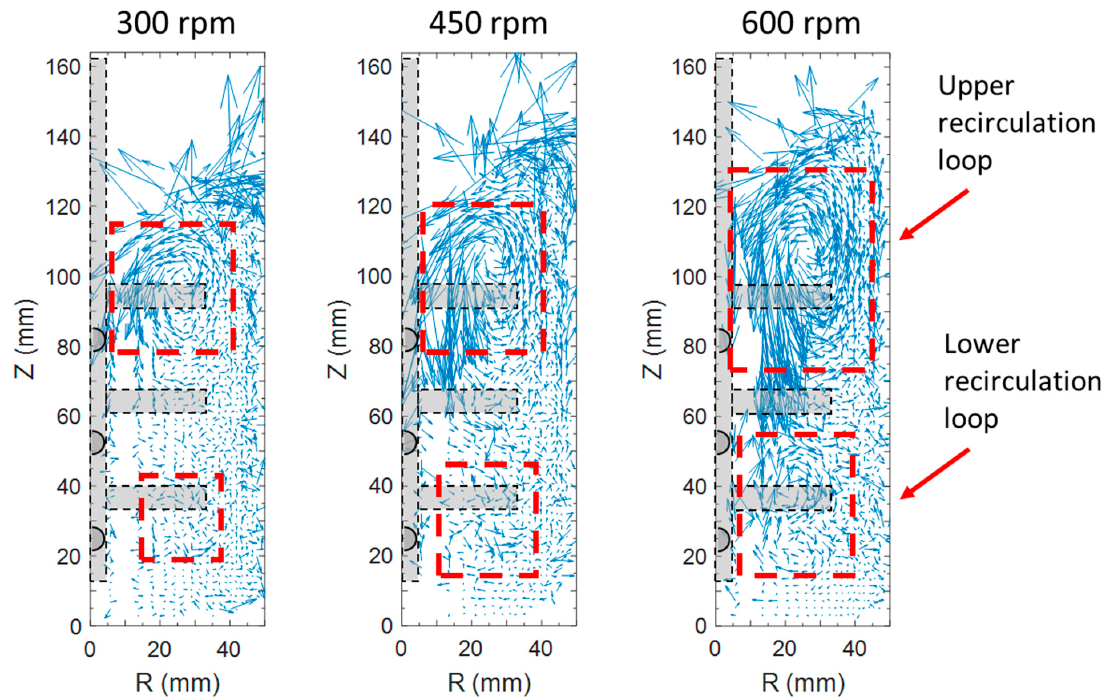
Figure 5. PEPT velocity vector maps for the impeller speed of 300 rpm, 450 rpm and 600 rpm highlighting the recirculation patterns within the attritor. Test case using the bead loading of 2.4 kg and the bottom clearance of 12.7 mm.